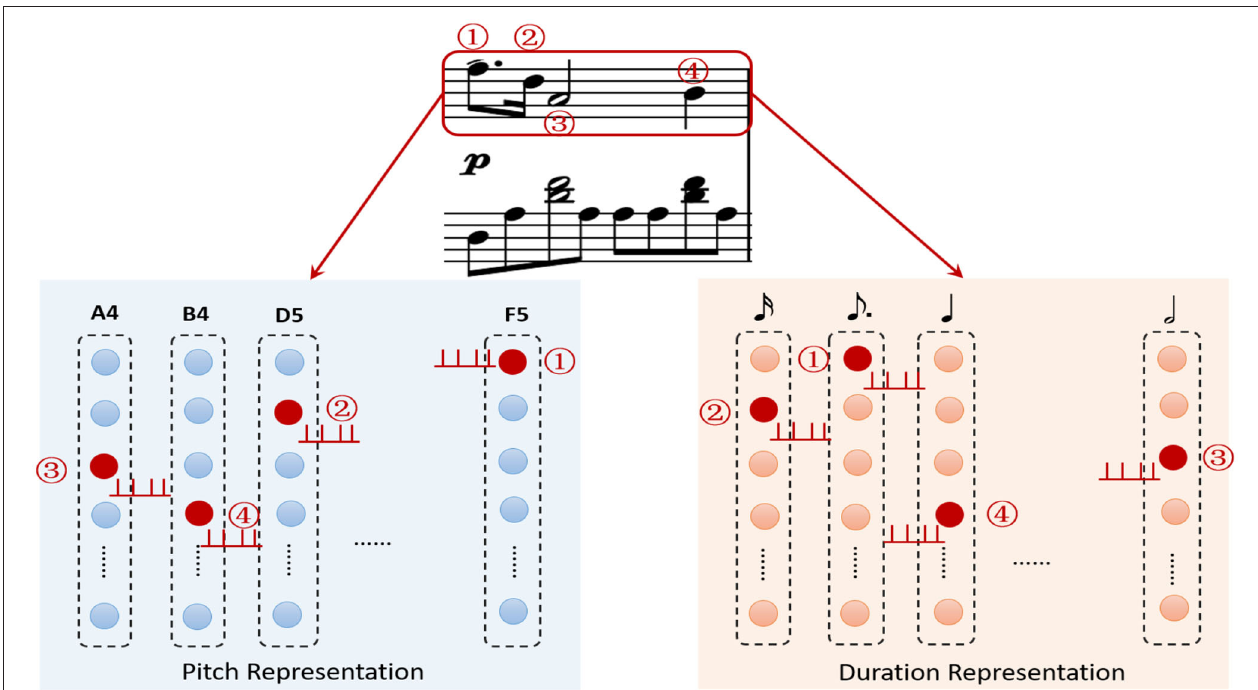
FIGURE 3 | The description of note encoding, the pitch of a note is represented by the minicolumn which prefers it. The duration subnetwork encodes the duration of a note in the same way. The ordered relationships of the notes are stored by the layers of these